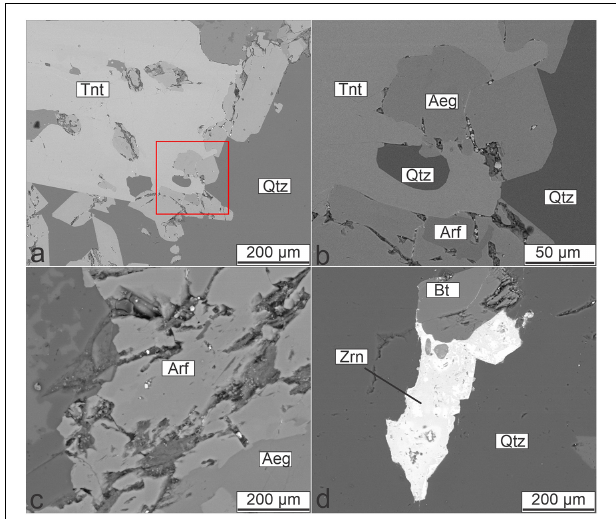
FIGURE 4 | Backscattered electron (BSE) images showing typical textures in the MMEs. (a) BSE image of the mantling texture showed in Figure 3C . (b) Enlargement of the area in the red box in (a) . (c) Replacement of arfvedsonite by aegirine. (d) Zircon associated with biotite and quartz.